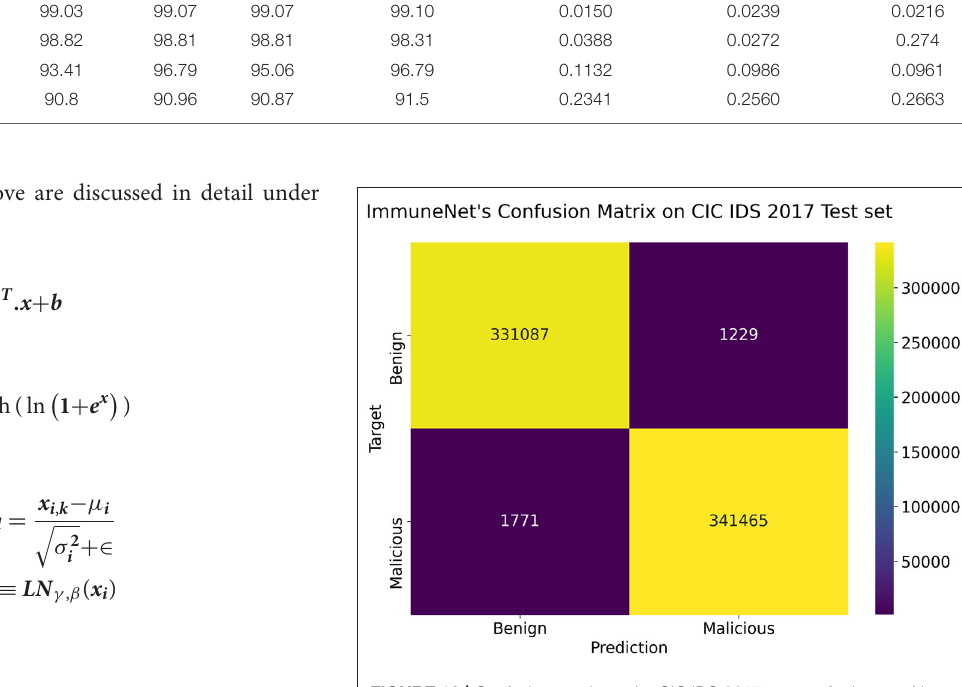
FIGURE 10 | Confusion matrix on the CIC IDS 2017 test set for ImmuneNet.